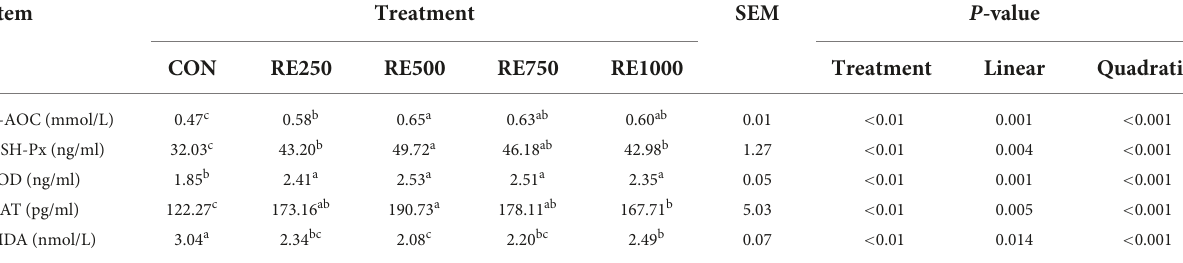
TABLE 5 Effects of rosemary extract on serum antioxidative parameters of broilers 1 .